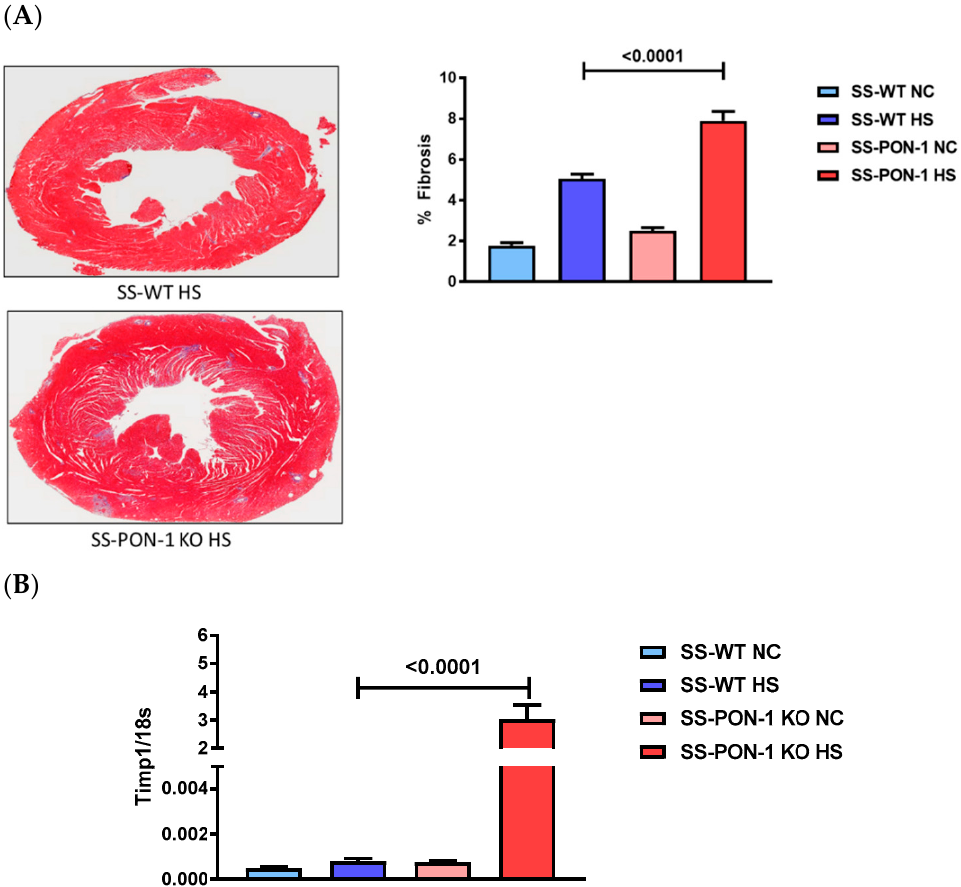
Figure 4. Targeted mutation of paraoxonase-1 leads to increased cardiac fibrosis in a hypertensive renal disease model. ( A ) Collagen area (pixels) ( N = 8) and ( B ) gene expression of Timp-1 in cardiac tissue as assessed by RT-PCR from SS-PON-1 KO and SS-WT rats after 5 weeks of 8% high-salt diet ( N = 8). SS-PON-1 KO HS rats display significant increase in cardiac fibrosis, compared to SS-WT HS rats following 5 weeks of 8% high-salt diet. Data are presented as the mean ± standard error of the mean. One-way ANOVA and post hoc multiple comparison tests were used to assess statistically significant differences between the groups.